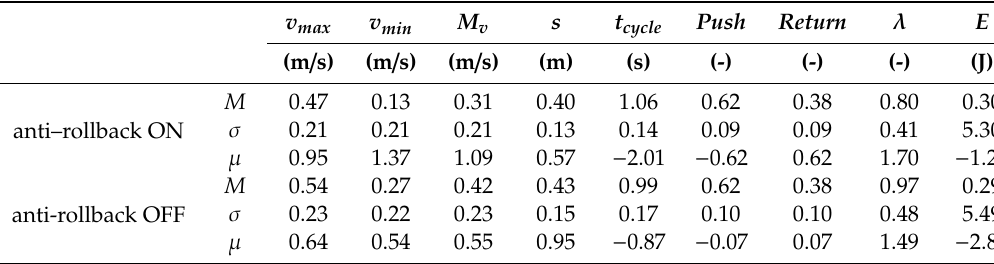
Table 2. The comparison of the average tested kinematic parameters during ramp climbing with the activated anti-rollback system and with the deactivated anti-rollback system, where M -mean, σ —standard deviation, µ —distribution skewness coe ffi cient (the description of the kinematic parameter symbols is provided in the